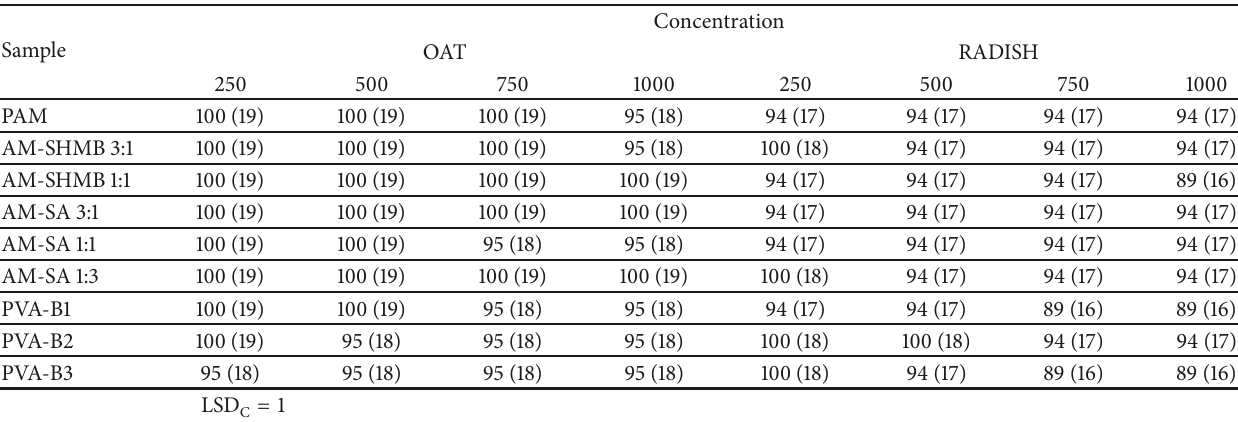
Table 5: Average values (mean of three replicates) of percent germination of oat ( Avena sativa) and common radish (Raphanus sativus ) treated with tested hydrogels. Least significant differences for samples (LSD S ) and concentration (LSD C ) are given at the bottom of the table. % germination refers to the number of emerged plants (in brackets) expressed as a percent of control plants. Concentration of samples is given in mg/kg of soil dry